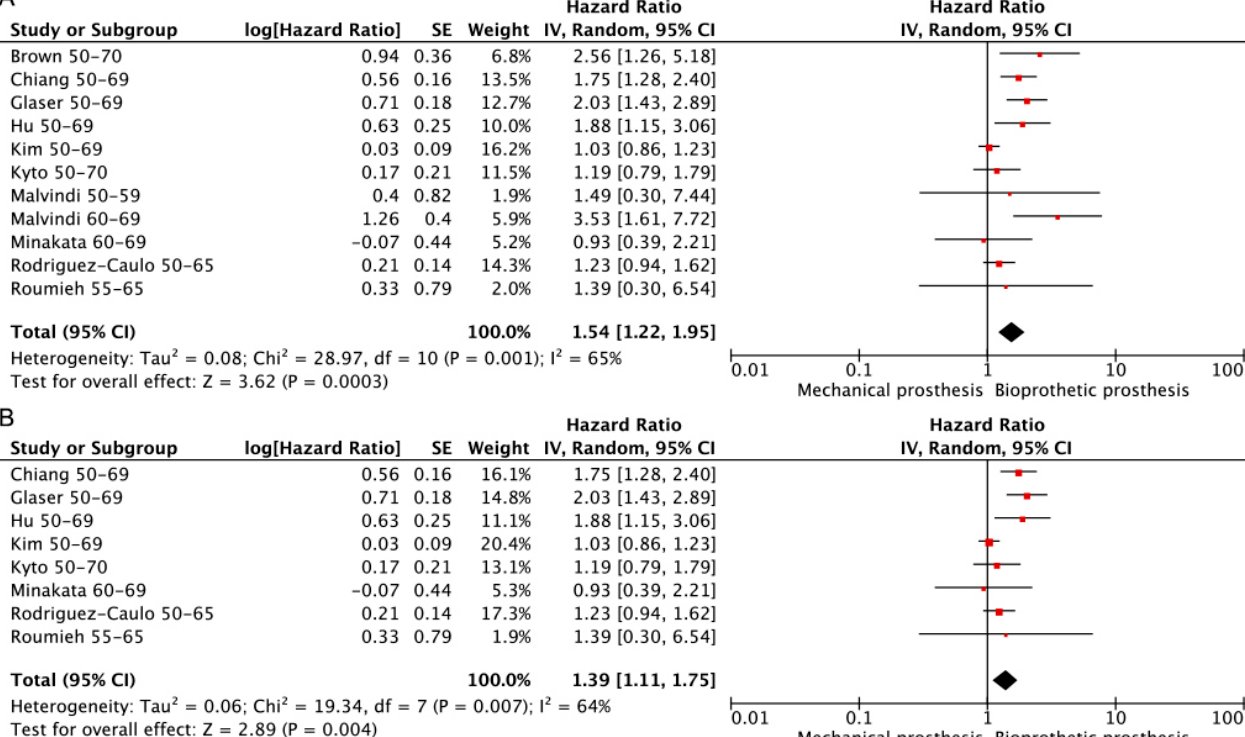
7A. Bioprosthetic vs. mechanical (RCT or PSM)—HR: 1.39; 95% CI: 1.11–1.75, Figure 7B).